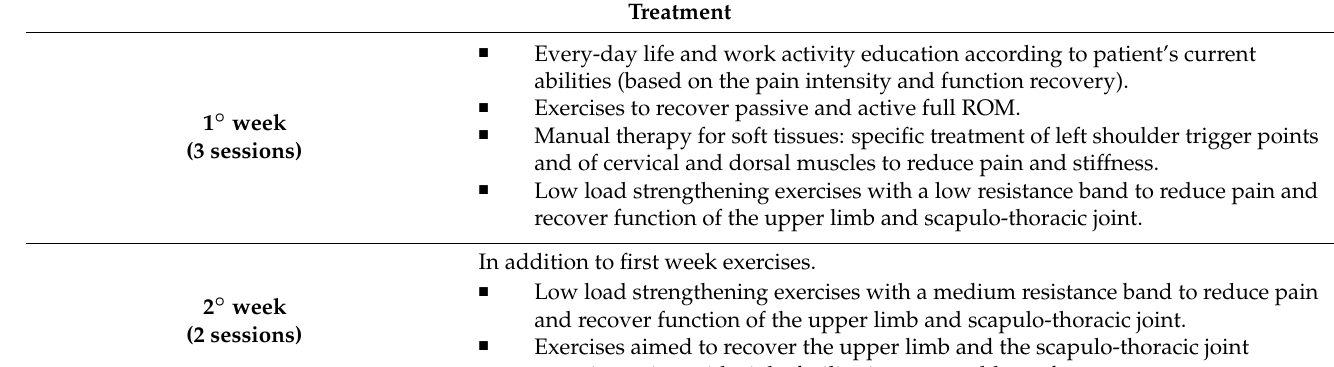
Table A1. Functional recovery program.